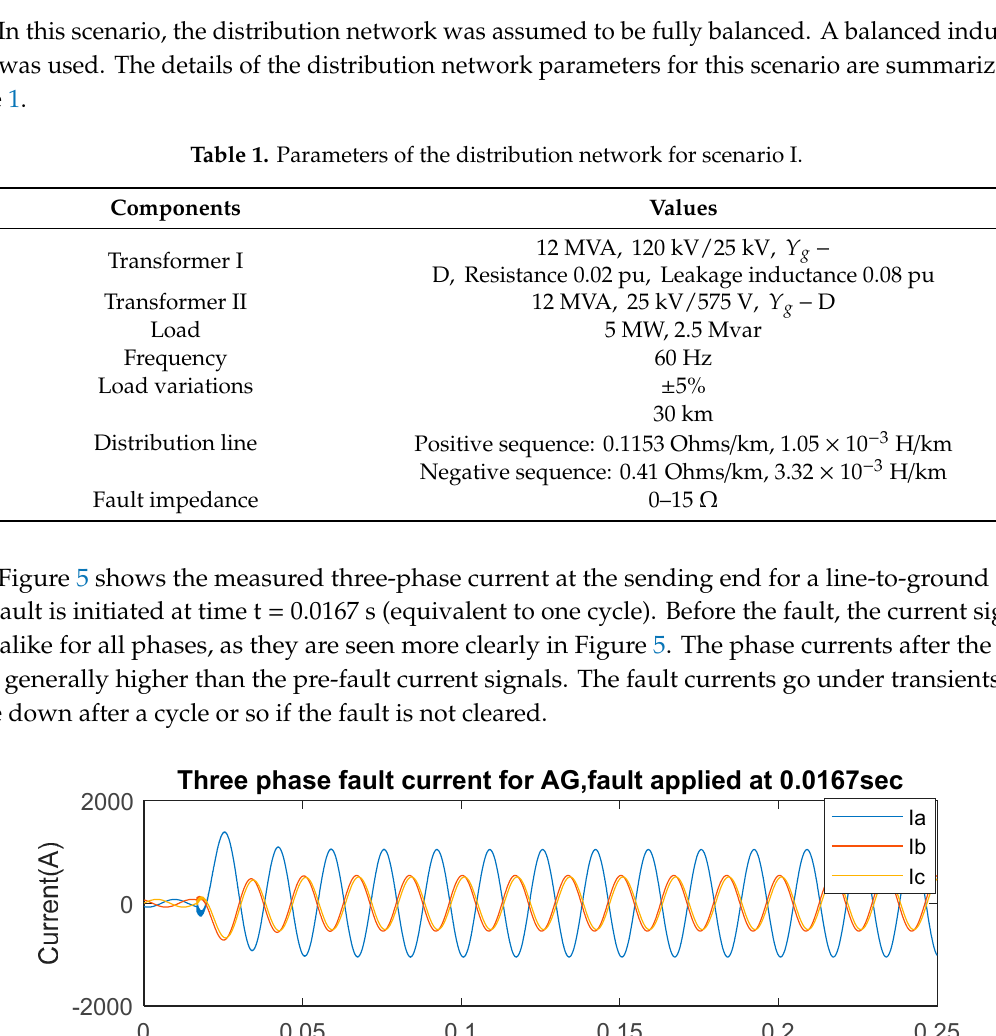
Figure 6. Useful features’ extraction from three-phase current signals and DWT: Approximate and detailed coefficients of phase A for a SLG fault applied on phase.